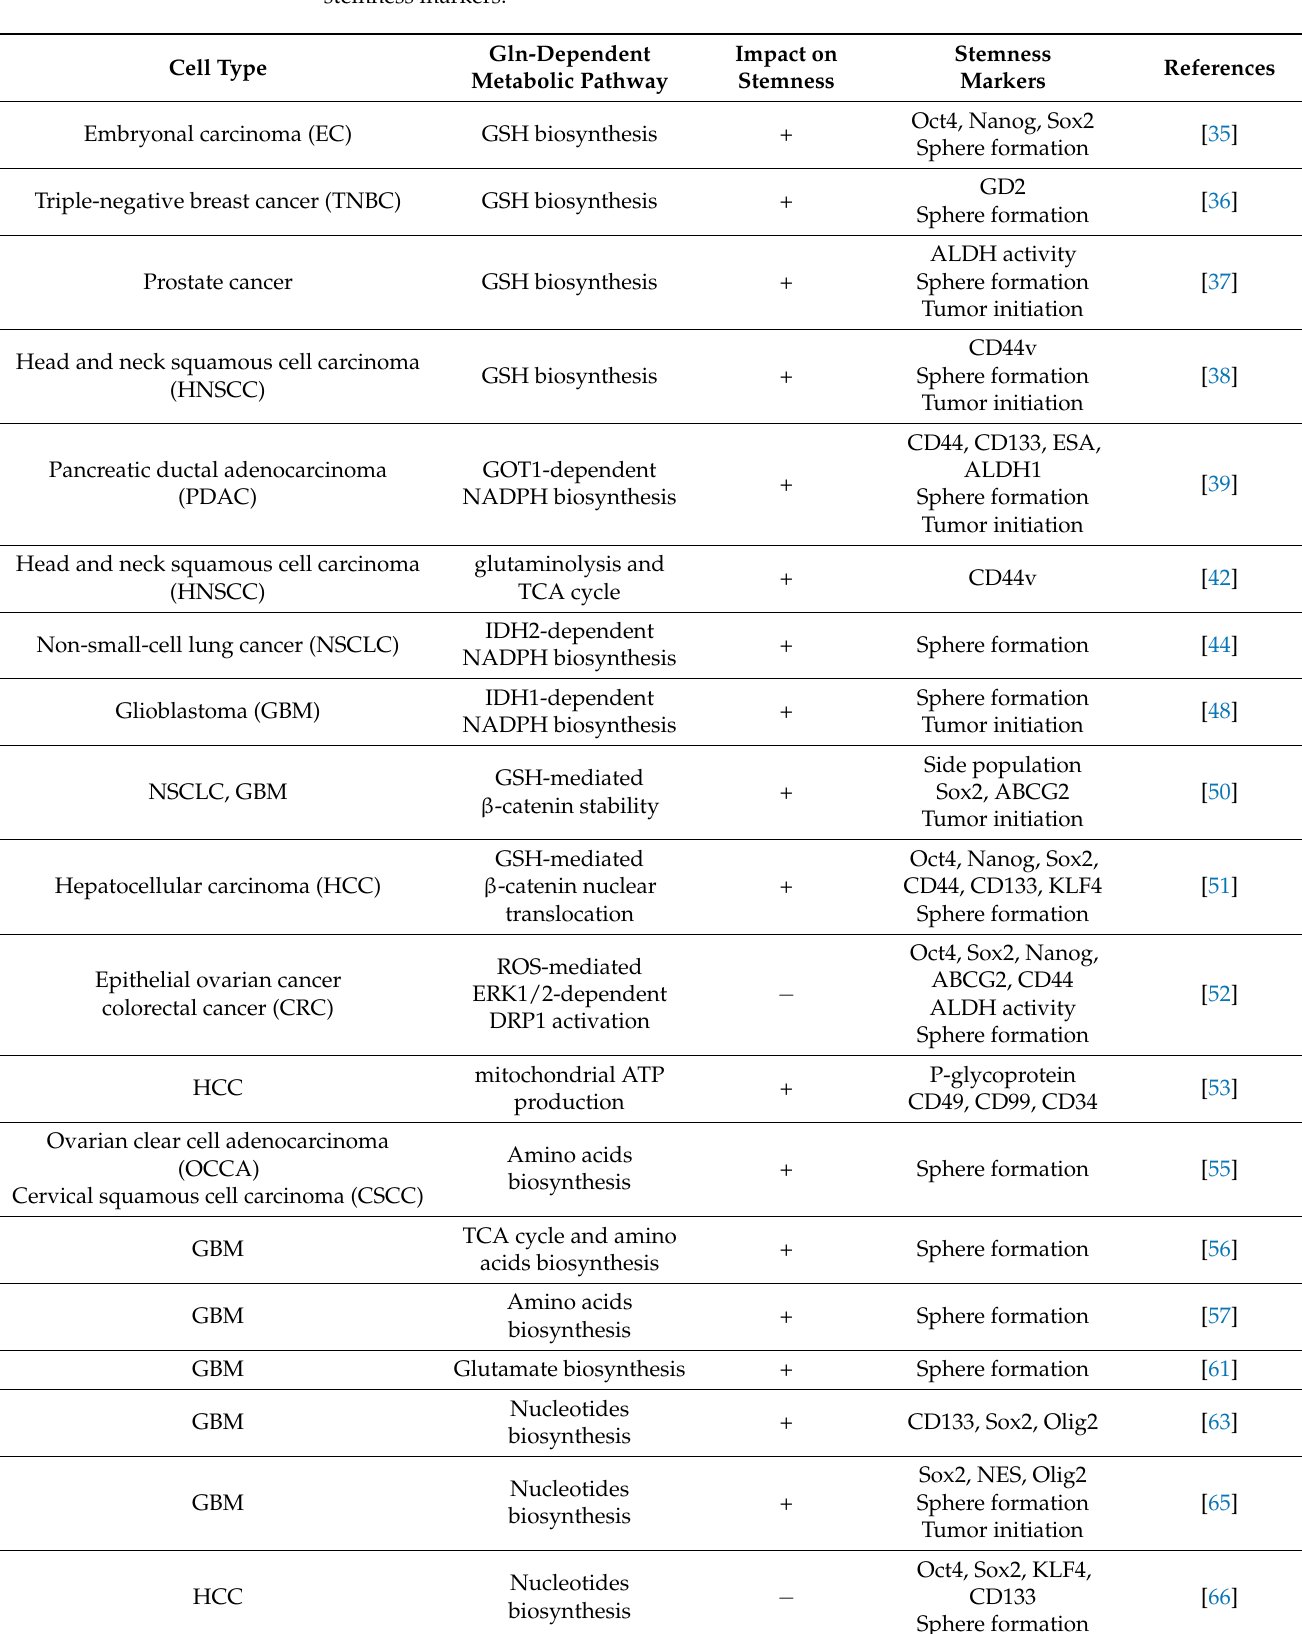
Table 1. Main glutamine metabolic pathways activated in CSC, their effects on cancer stemness, stemness